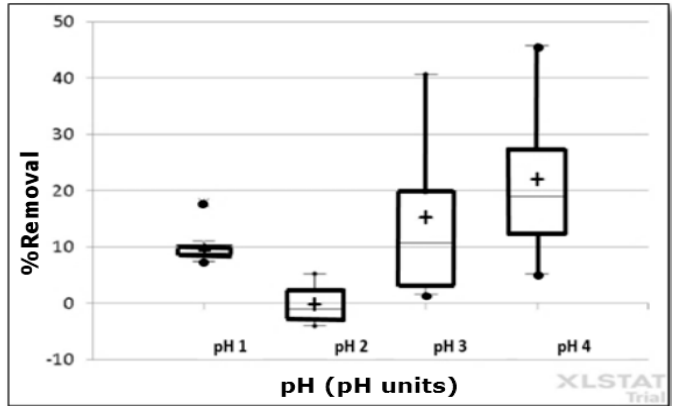
Figure 2. Optimum pH determination of the CP for Mn (II) removal.